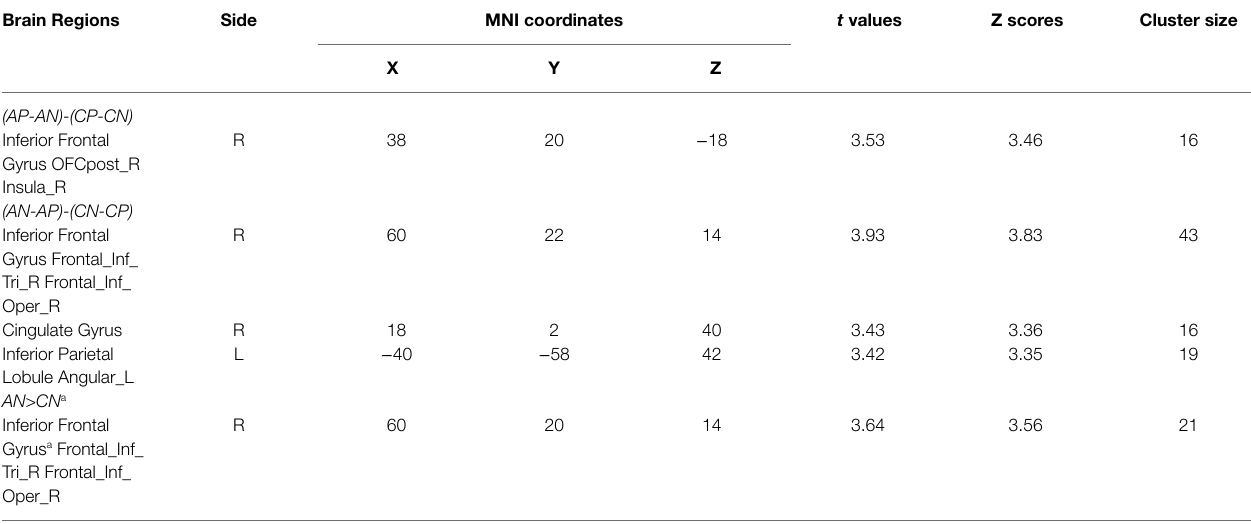
TABLE 3 | Activations associated with the interaction between priming and valence processing. Brain